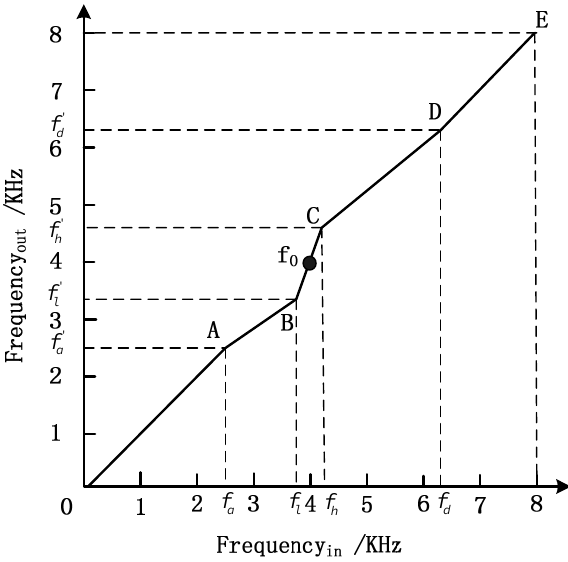
Figure 1. The relationship between frequencies before and after piecewise ‐ linear frequency shifting.